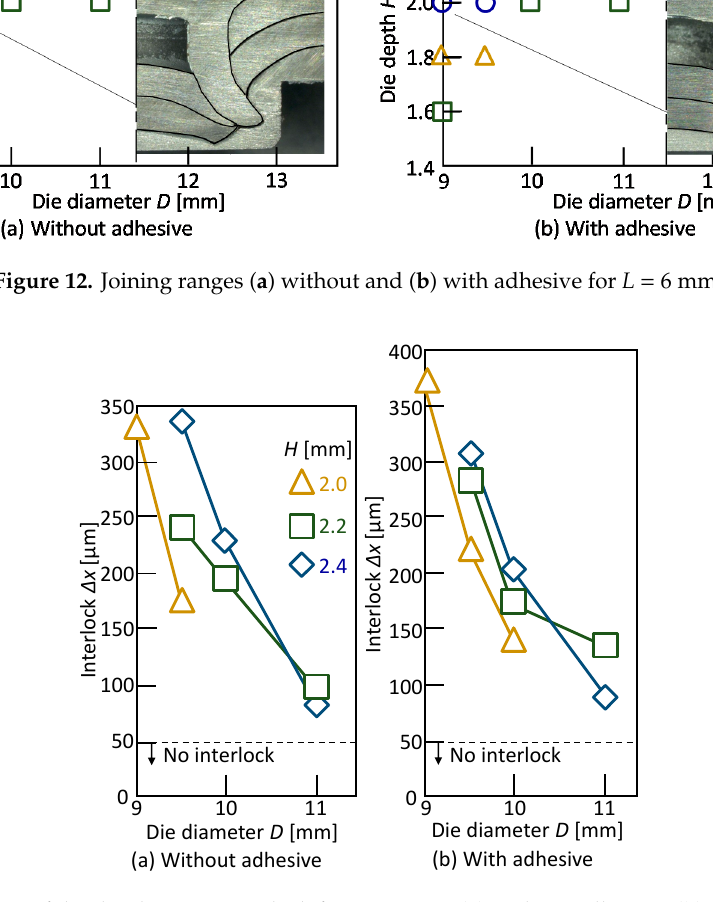
Figure 13. E ff ect of the die shape on interlock for L = 6 mm: ( a ) without adhesive; ( b ) with adhesive.